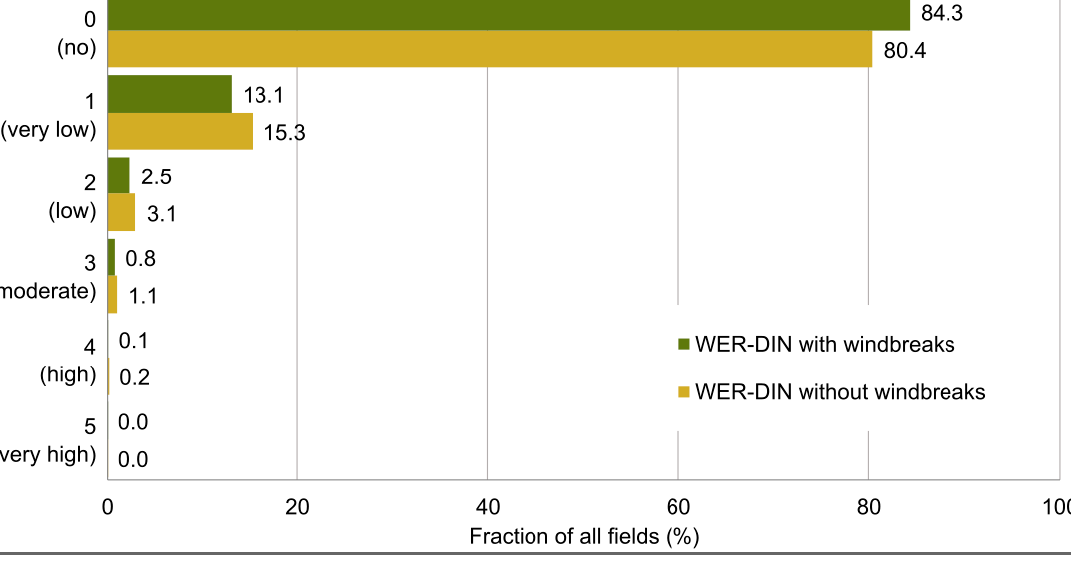
Figure 9. Alteration of the percentage of wind erosion risk of fields within the study by including windbreaks in the risk assessment